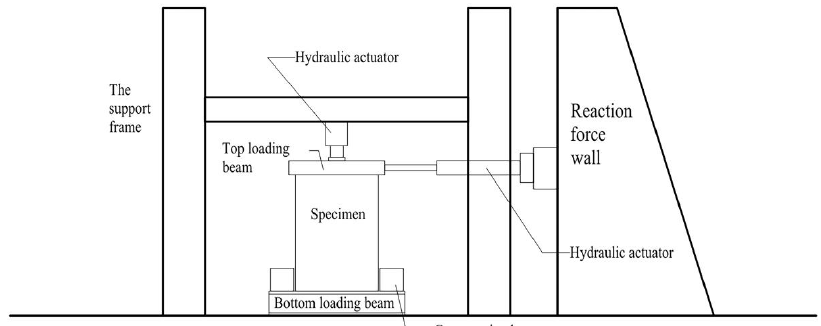
Figure 2. The loading system.